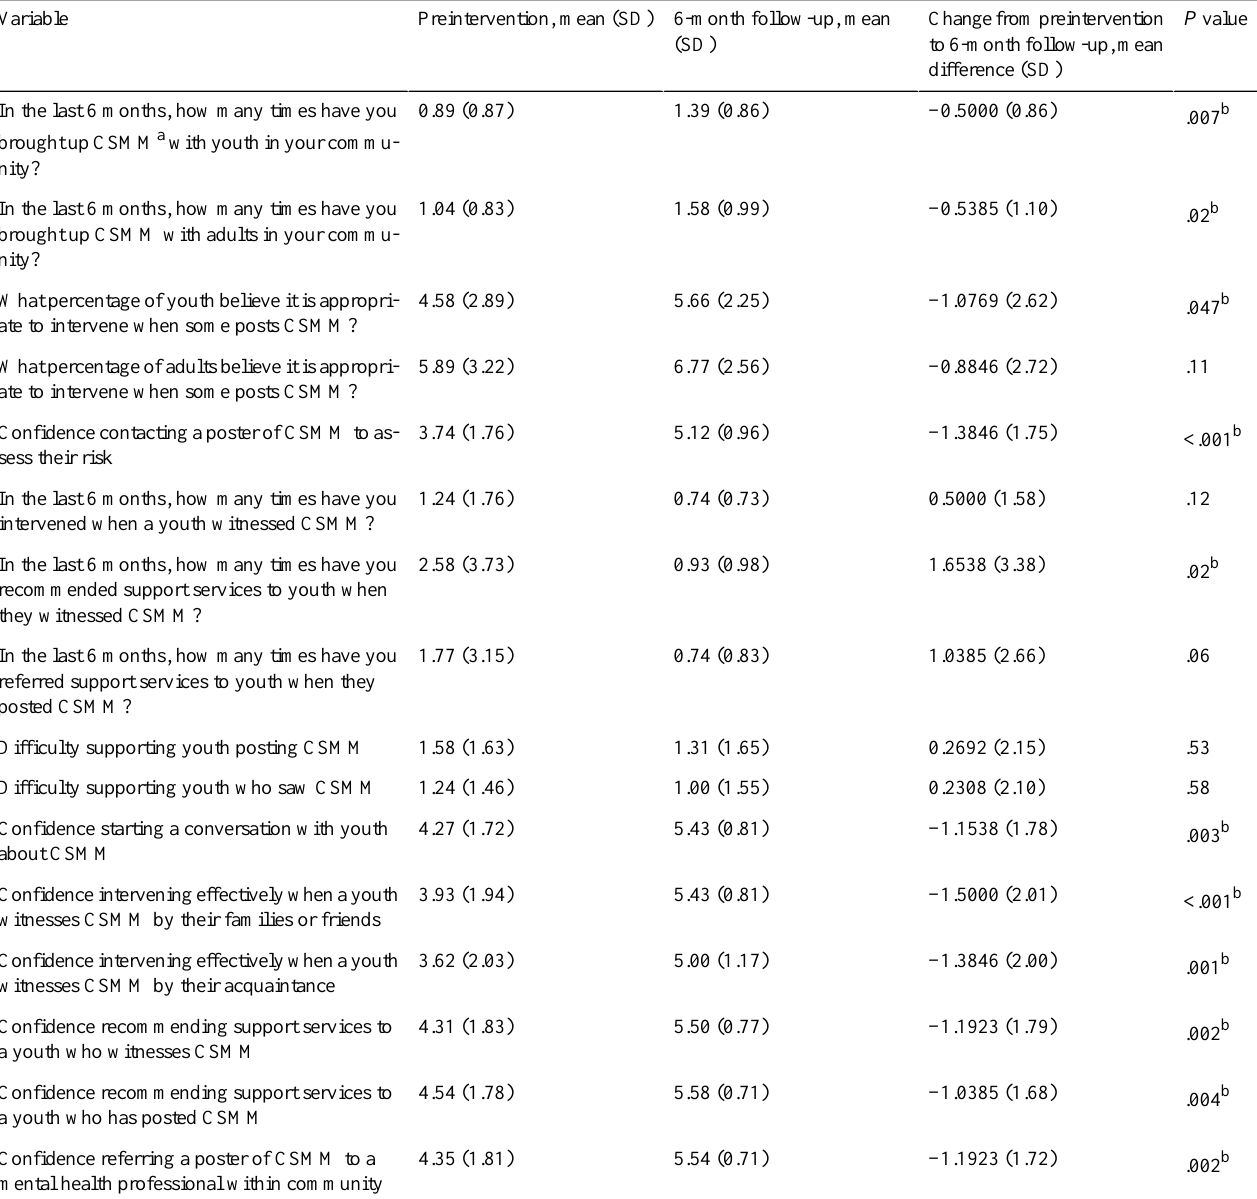
Table 4. Comparison of self-reported behavior from pre- to 6 months postintervention.